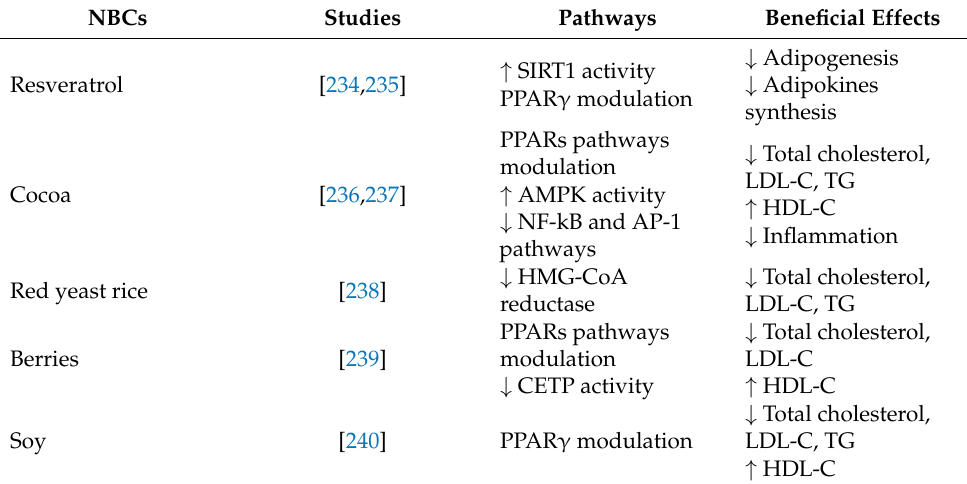
Table 5. NBCs in lipid profile